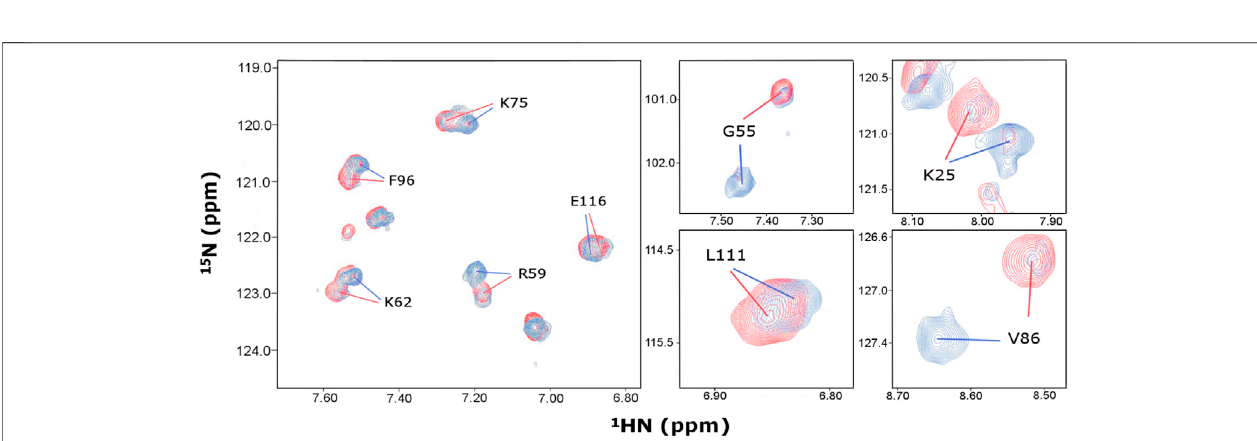
FIGURE 2 | Identi fi cation of distinct chemical shift assignments at 466 and 153 μ M P protein concentrations. Overlay of 1 H, 15 N-HSQC spectra acquired on samplescontaining466 μ M(red)and153 μ M(blue)Pproteinconcentrationsunderidenticalbufferconditionsat318K.Representativeregionsofthespectraareshown, revealingslowexchangebetweenmonomeranddimerconformersinsolution.Aminoacid singlelettercode and T.maritima RNasePprotein numbering correspondsto UniProtKB – Q9X1H4.